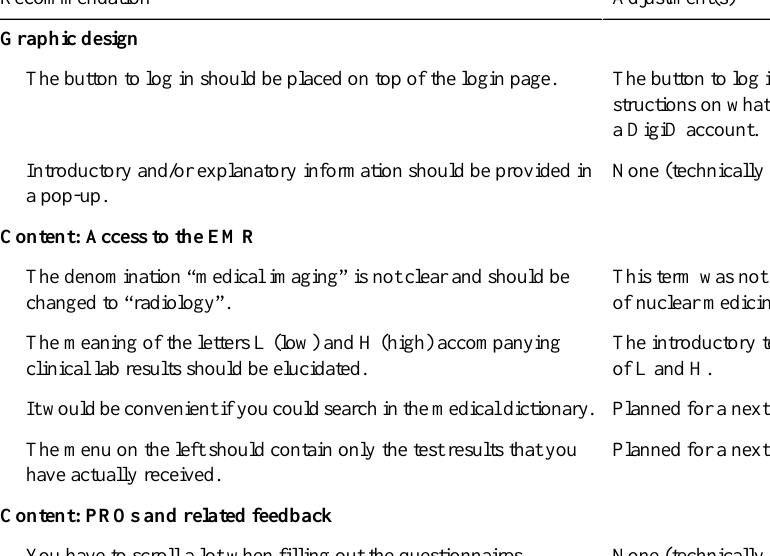
Table 2. Recommendations and adjustments based on usability tests (N=7).